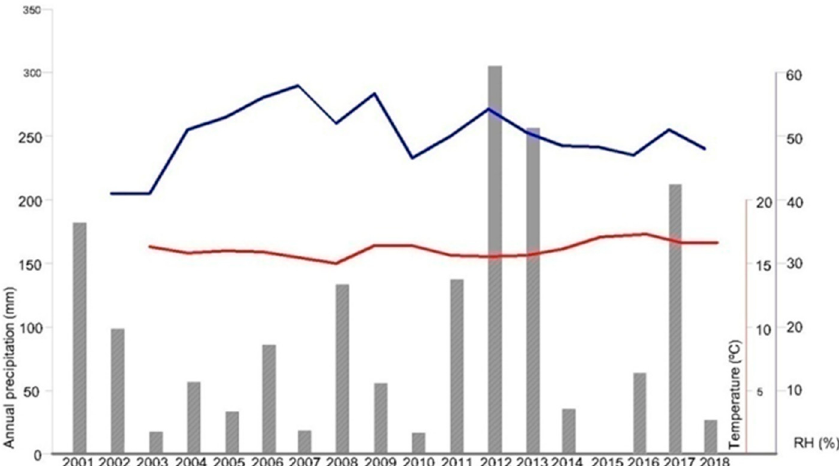
Figure 12. Annual precipitation, temperature and relative humidity data .